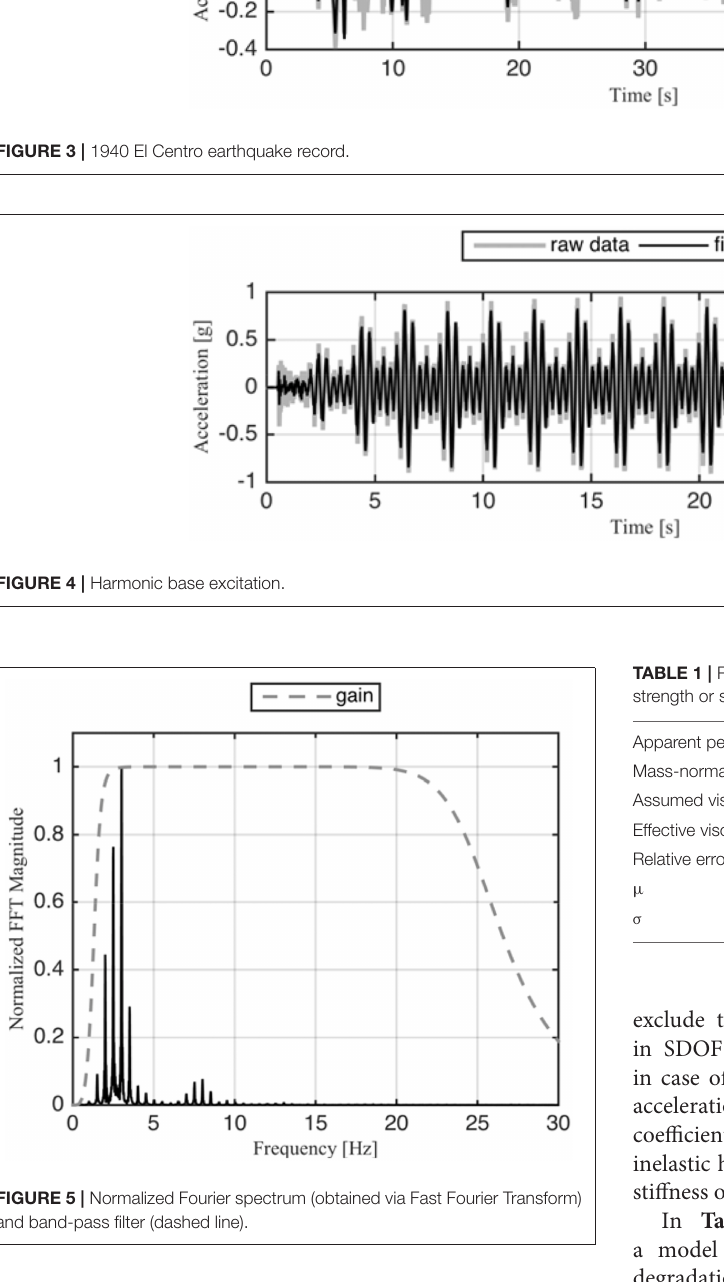
offset before integrating the acceleration data to estimate the velocity and displacement responses. A low-pass Butterworth filter of 17 Hz with the order of 9 is also applied to either